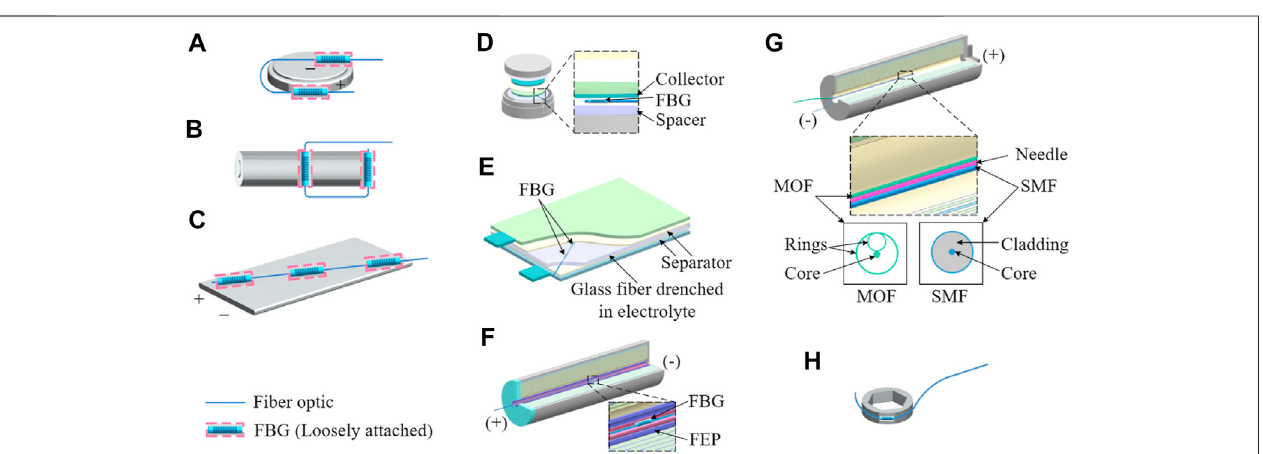
FIGURE4 | FBG sensors on thesurface and insidevariouscell types (Weiet al., 2021;Panel6, p.15). (A) FBG on coin cells and (B) FBG on a cylindrical cell (Yang et al., 2013), (C) FBG on a prismatic cell (Nascimento et al., 2017), (D) FBG in a coin cell (Fortier et al., 2017), (E) FBG in a pouch cell, (F) FBG in a cylindrical cell (Amietszajew et al., 2018; Fleming et al., 2018; McTurk et al., 2018), (G) FBG in a cylindrical cell (Huang et al., 2020), (H) FBG in a coin cell (Peng et al., 2020). Reprinted from (Wei et al., 2021), Copyright (2021) with permission from Elsevier.